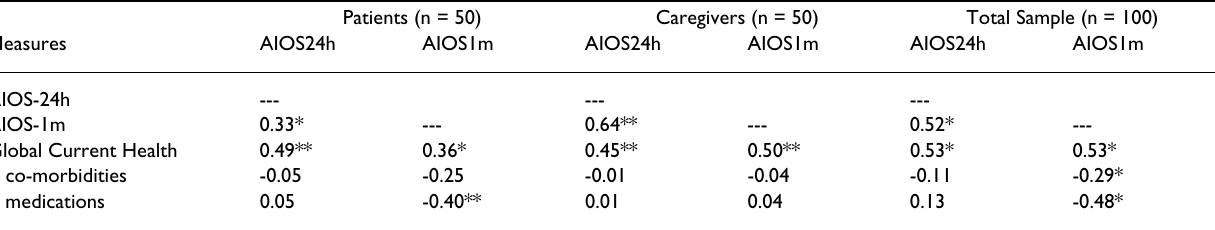
Table 2: Pearson Correlation Coefficients between AIOS Ratings, Global Health Rating, and Clinical